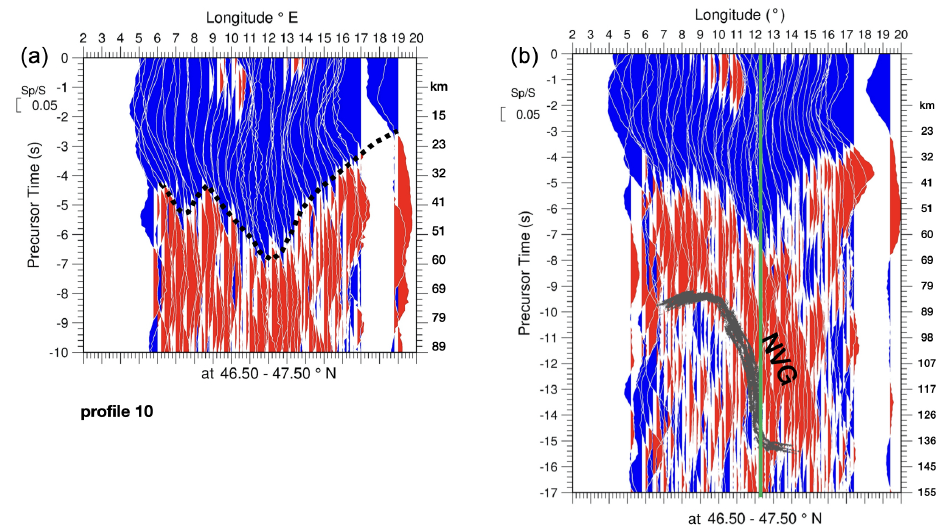
Figure 12. Profile 10. East–west profiles at 46.5–47.5 ◦ N, largely running within the European plate and straddling the plate boundary east of 11.5 ◦ E. Note the vertical exaggeration of around 13 times in this E–W profile and those of Figs. 13 and 14. (a) Approximate onsets of Moho signals along this profile are marked by a dotted black line. (b) The grey shadow indicates the base of the NVG; the vertical green line marks a very pronounced along-strike change at around 13 ◦ E that is discussed in the text. Panel (b) shows the clearest observation in the entire area of the steeply dipping NVG.